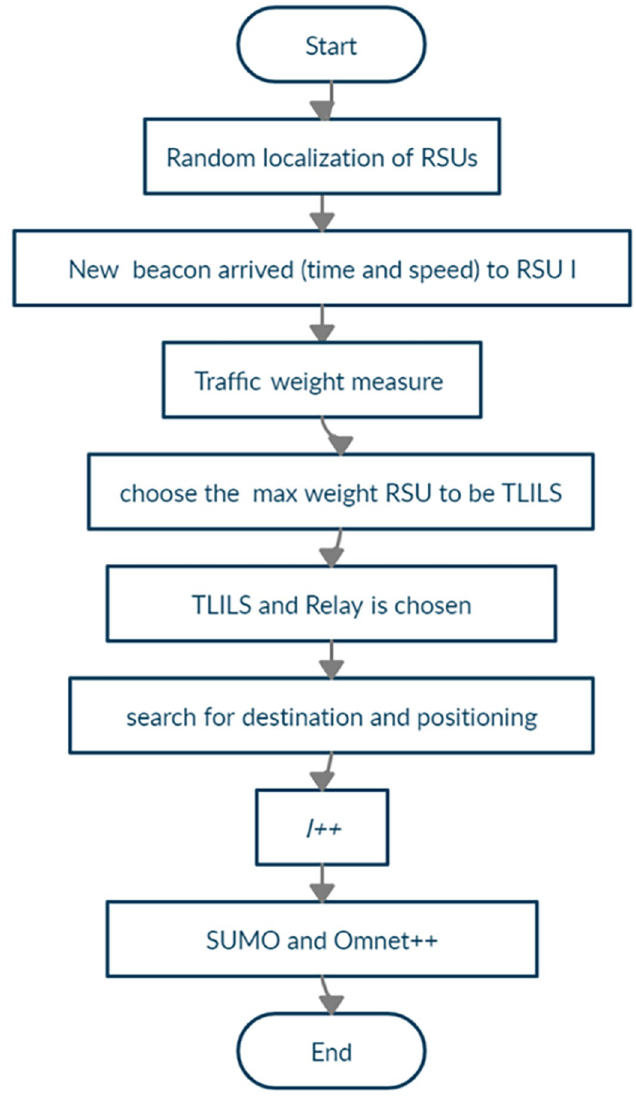
Fig 1. The execution procedure for the optimized 5G traffic-based location